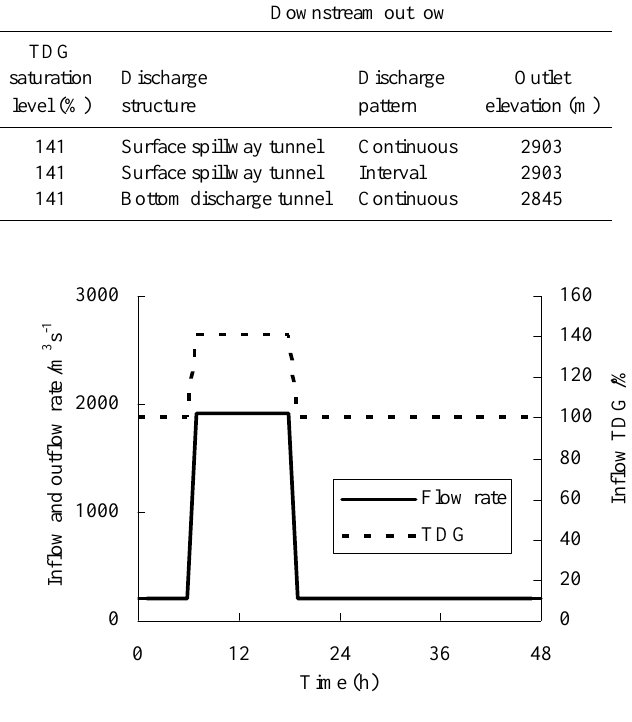
Fig. 4. The flow and TDG boundary conditions for Case 1 and Case 3.